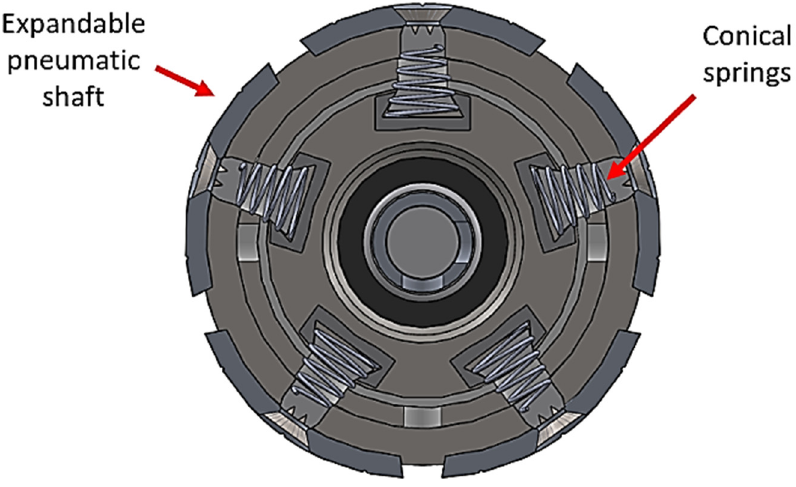
Figure 12. Sectional view of the XY plane of the expandable pneumatic shaft’s mechanism. The winder’s pneumatic shaft spring is held inside a U-shaped aluminum profile, with the flaps more closed, and it is through these flaps that the spring remains fixed.